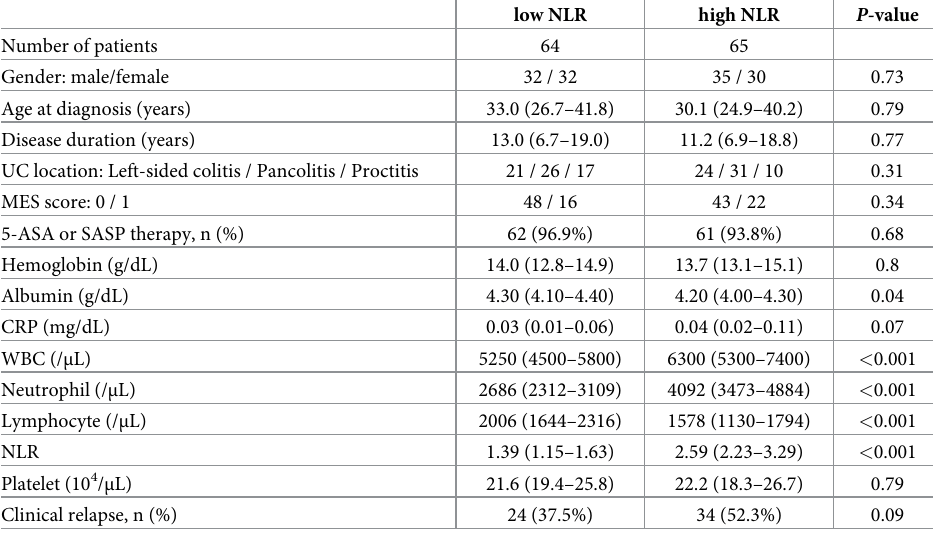
Table 2. Comparison between low NLR and high